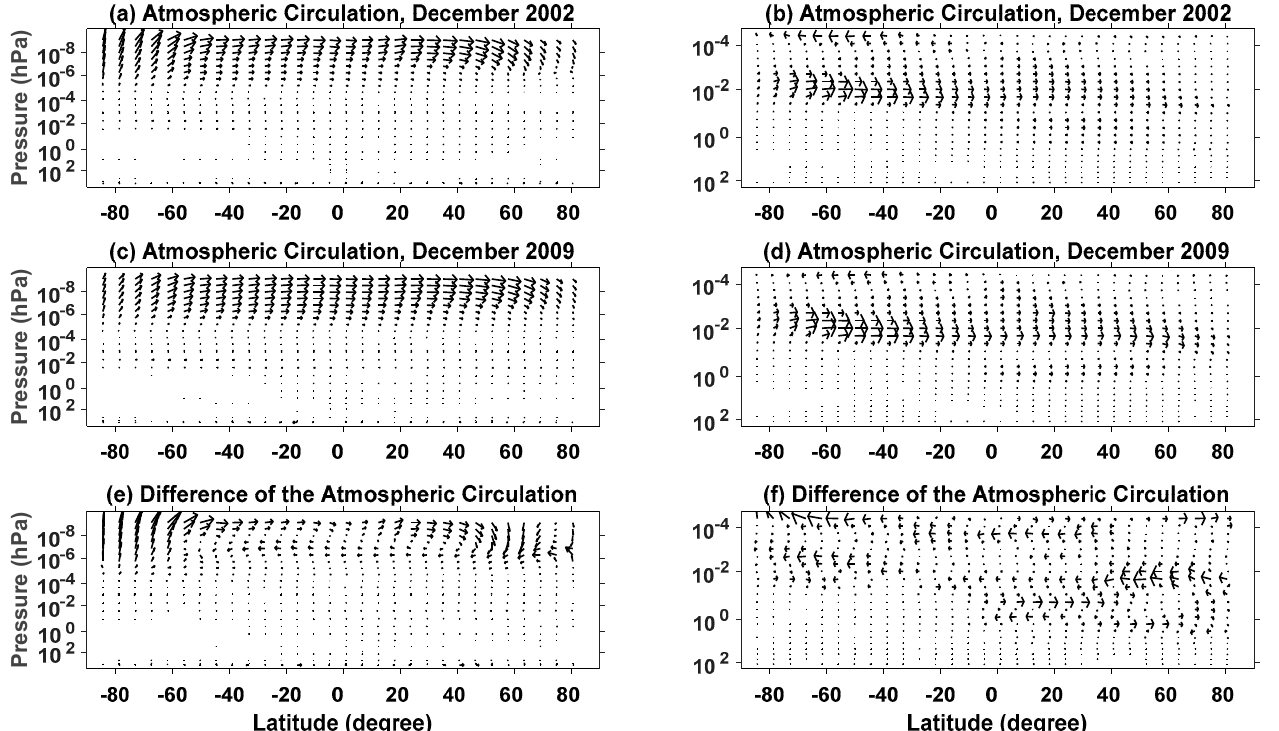
Figure 7. Atmospheric circulation in June ( a , b ) 2002 and ( c , d ) 2009. ( e , f ) Differences in the atmospheric circulation in June between 2002 and 2009. Left and right panels show the atmospheric circulation in the global atmosphere and in the middle and lower atmosphere, respectively.